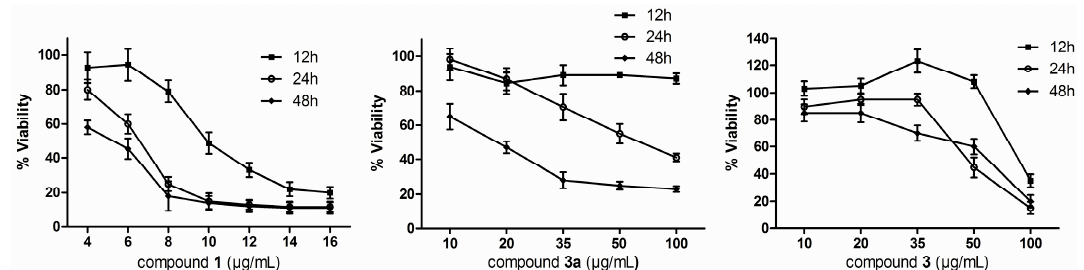
Figure 4. MTT assays showed the cytotoxicity on cancer cell lines.